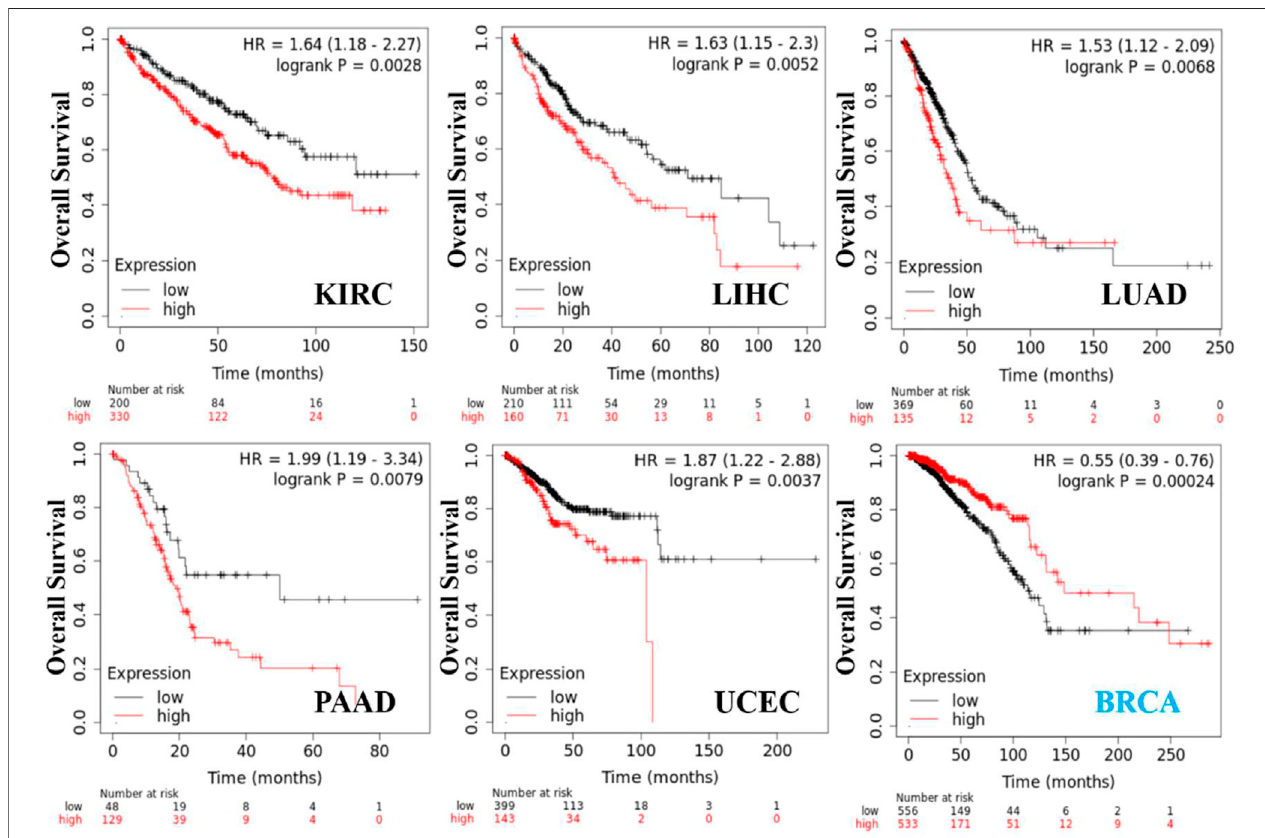
FIGURE4| KRT17expressioninOSinKIRC,LIHC,LUAD,PAAD,UCEC,andBRCA.WeobtainedarelationshipbetweenKRT17andsurvivalprognosisofcancer from Kaplan – Meier Plotter. Kaplan – Meier curves were all positive. The solid red line represents the high expression of KRT17 in tumor tissues, and the solid black line represents the low expression of KRT17 in tumor tissues.